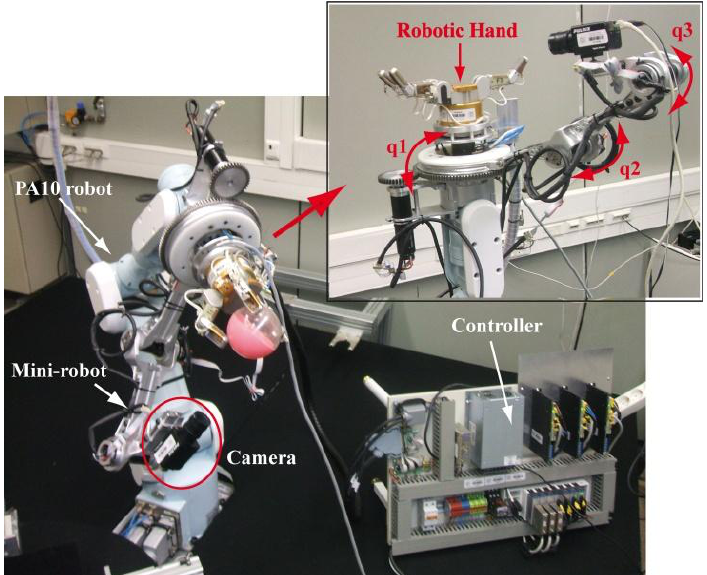
Figure 4. Multi-robot system